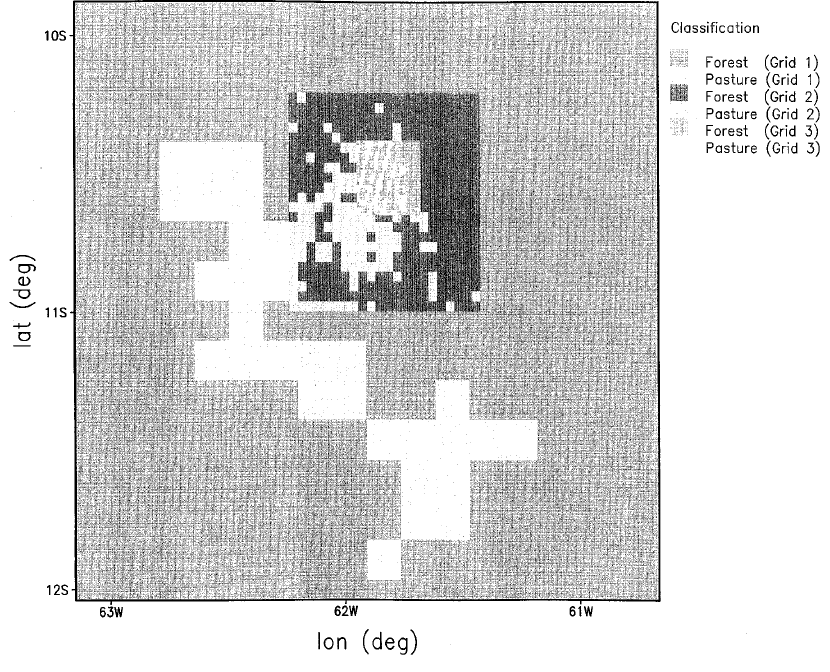
Fig. 8. Nested simulation domains for the